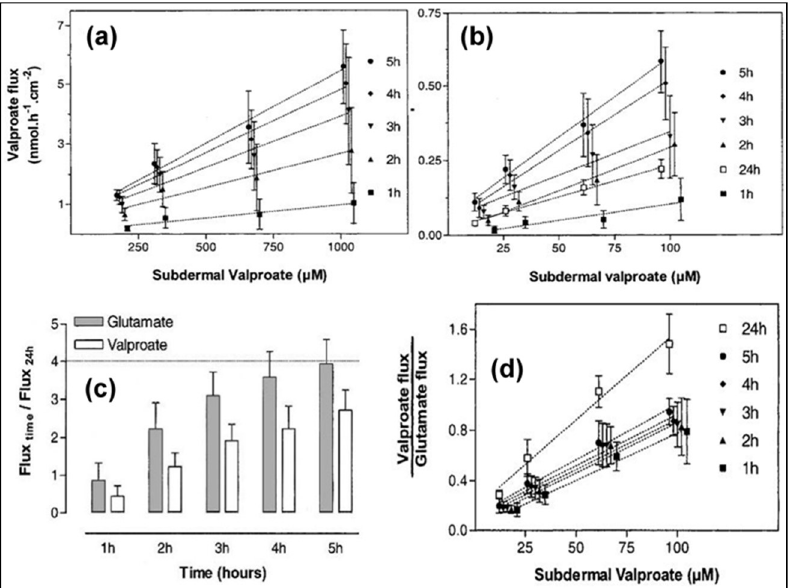
Figure 2. Reverse iontophoretic extraction flux rates of valproate as a function of time and subdermal concentration ( a ) in the range 209–1050 µM, and ( b ) in the range 21–104.5 µM. Reverse iontophoretic extraction flux rates of valproate and glutamate as a function of time relative to their values at 24 h. ( c ) Ratio of the reverse iontophoretic extraction flux rates of valproate and glutamate as a function of time and subdermal valproate concentration (range 21–104.5 µ M). ( d ) Each data point represents the mean ± standard deviation (n = 6) [17].